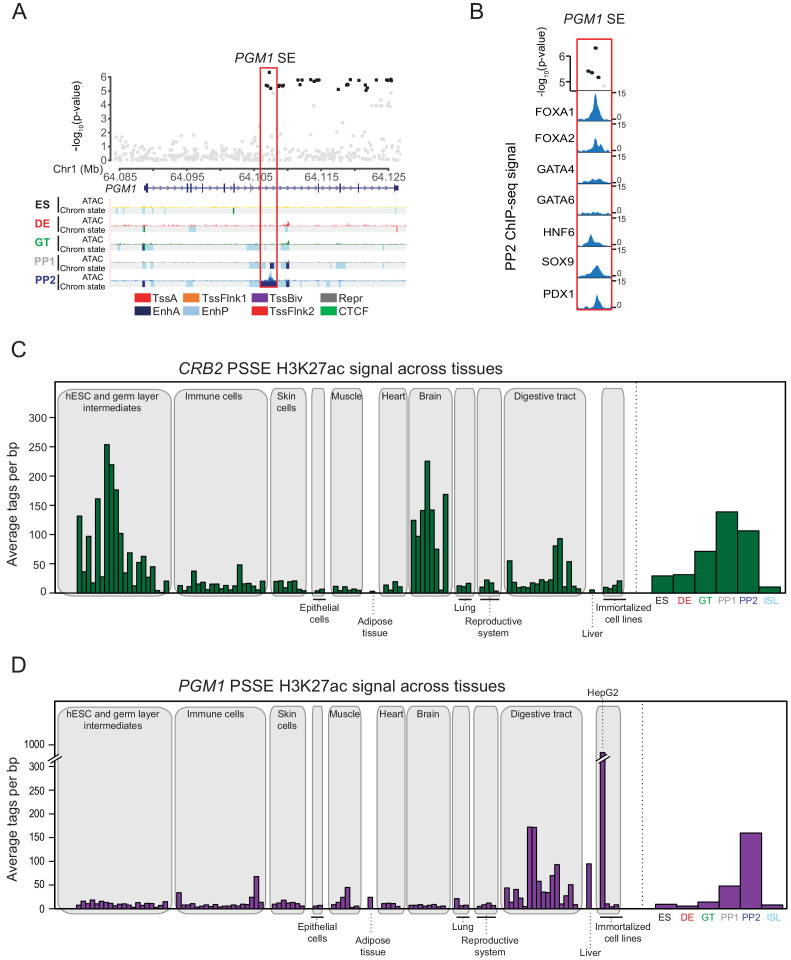
Activity of CRB2- and PGM1-associated pancreatic progenitor-specific stretch enhancers across human tissues.(A) (Top) Locus plots showing T2D association p-values for variants in a 43 kb window (hg19 chr1:64,084,000–64,127,000) at the PGM1 locus and PGM1 PSSE (red box). Fine mapped variants within the 99% credible set for the novel PGM1 locus are colored black. All other variants are colored light gray. (Bottom) Chromatin states and ATAC-seq signal in ES, DE, GT, PP1, and PP2. TssA, active promoter; TssFlnk, flanking transcription start site; TssBiv, bivalent promoter; Repr, repressed; EnhA, active enhancer; EnhP, poised enhancer. (B) FOXA1, FOXA2, GATA4, GATA6, HNF6, SOX9, and PDX1 ChIP-seq profiles at the PGM1 PSSE in PP2 cells. The variants rs2269247, rs2301055, rs2301054, and rs2269246 (black) overlap with transcription factor binding sites. (C) H3K27ac signal at CRB2-associated PSSE in tissues and cell lines from the ENCODE and Epigenome Roadmap projects as well as in developmental intermediates and islets (ISL). (D) H3K27ac signal at PGM1-associated PSSE in tissues and cell lines from the ENCODE and Epigenome Roadmap projects as well as in developmental intermediates and islets.